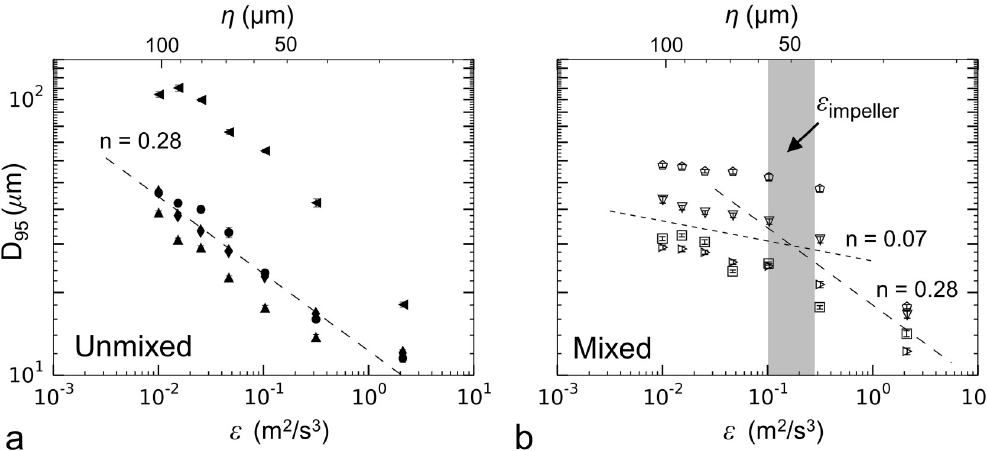
Fig 13. Plots of largest stable floc size vs. dissipation rate in the siphon tubes. (a) Unmixed aggregation tank conditions and (b) the mixed aggregation tank conditions are shown. Symbols consistent with Table